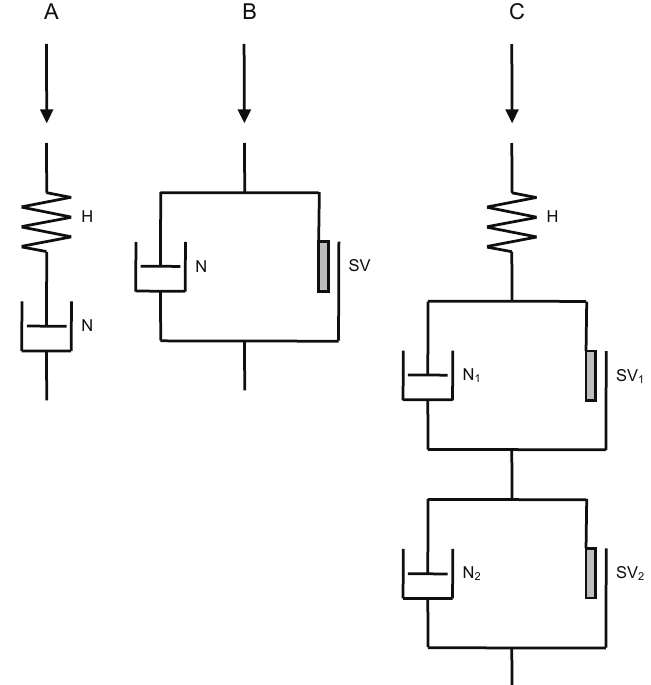
Figure 5. The structural rheological models: ( A ) The Maxwell’s body that consists of the Hookean spring (H) and the Newtonian dashpot (N), connected in series; ( B ) the Bingham’s body that consists of the friction block (i.e., Saint-Venant’s body (SV)) and the Newtonian dashpot, connected in parallel; and ( C ) a combination of the Hookean spring and two Bingham’s bodies, connected in series [35,36]. The arrows indicate